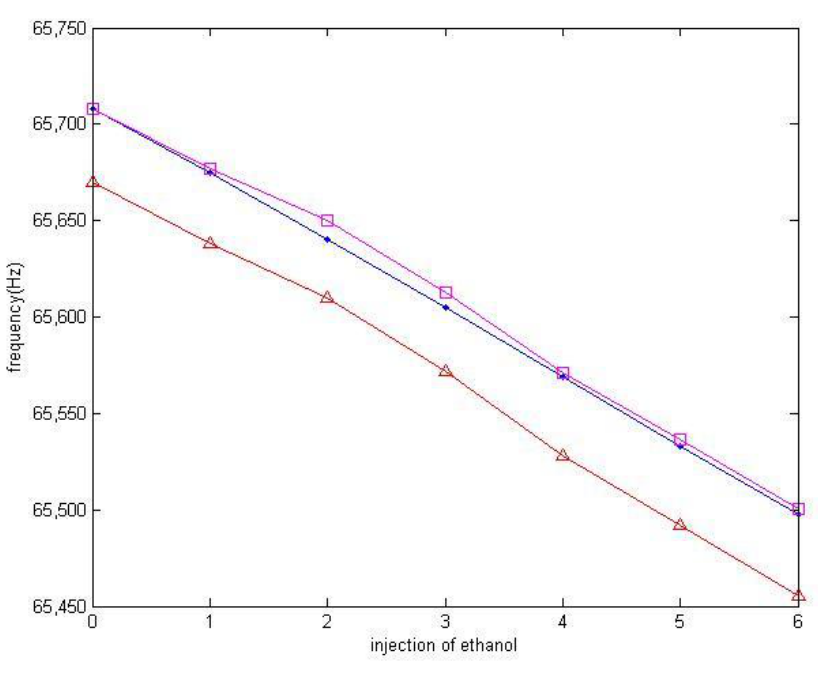
Figure 9. Frequency shift in response to the injection of ethanol. (a) MRF of the micro-cantilever in open-loop test [ ]. (b) SWF in close-loop test [ ]. (c) Simulation results of SWF [